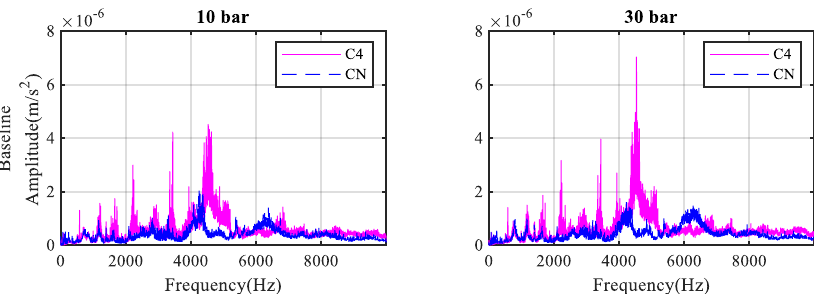
Figure 9. Spectrum of signals under different clearances and loads.